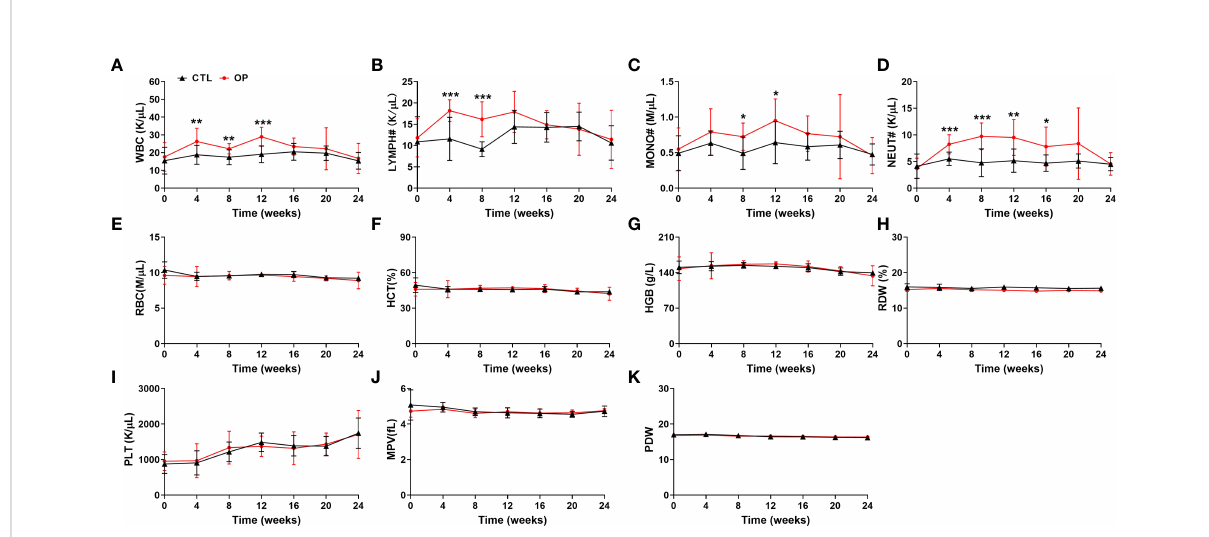
FIGURE 3 Detection of hematological indices in iron overload-induced osteoporotic mice. (A – K) The counts of WBC (A) , LYMPH# (B) , MONO# (C) , NEUT# (D) , RBC (E) , HCT (F) , HGB (G) , RDW (H) , PLT (I) , MPV (J) and PDW (K) were examined in iron overload-induced osteoporotic mice. n=12. * p <0.05, ** p <0.01, *** p <0.001 versus CTL. CTL, control group; OP, overload-induced osteoporotic group; WBC, white blood cells; LYMPH#, lymphocytes; MONO#, monocytes; NEUT#, neutrophils; RBC, red blood cells; HCT, hematocrit; HGB, hemoglobin; RDW, red cell distribution width; PLT, platelets; MPV, mean platelet volume; PDW, platelet distribution